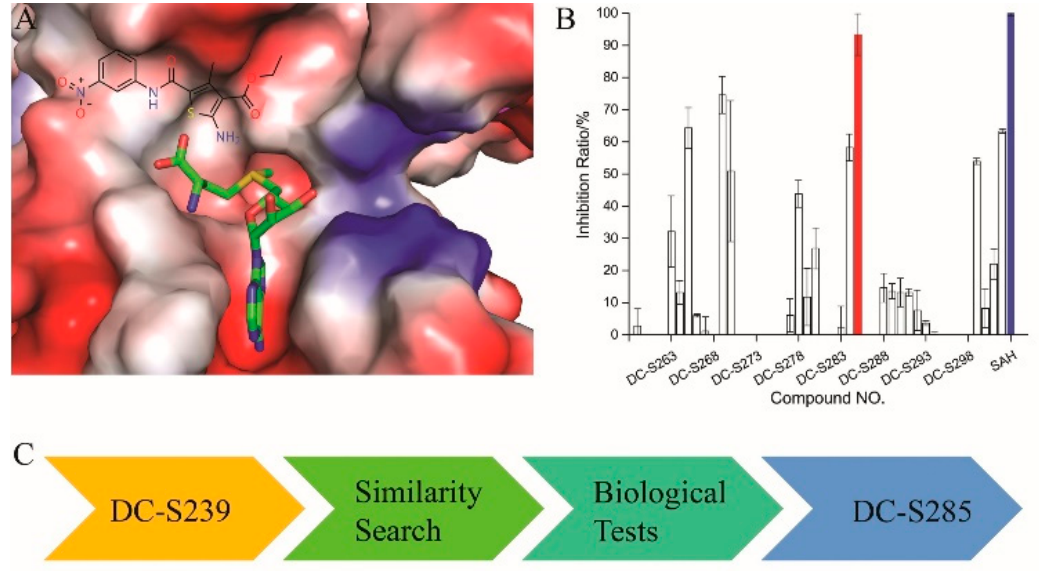
Figure 1. The flowchart of the combinatorial scaffold hopping and 2D fingerprint based similarity search strategies. ( A ) Chemical structure of DC-S239 and its predicted binding mode. DC-S239 is shown in sticks and the SET7 protein is shown in electrostatics surface; ( B ) Inhibition ratio of the compounds in first-round similarity search. DC-S285 is shown in red while the reference compound SAH is depicted in blue; ( C ) Workflow chart in the study.